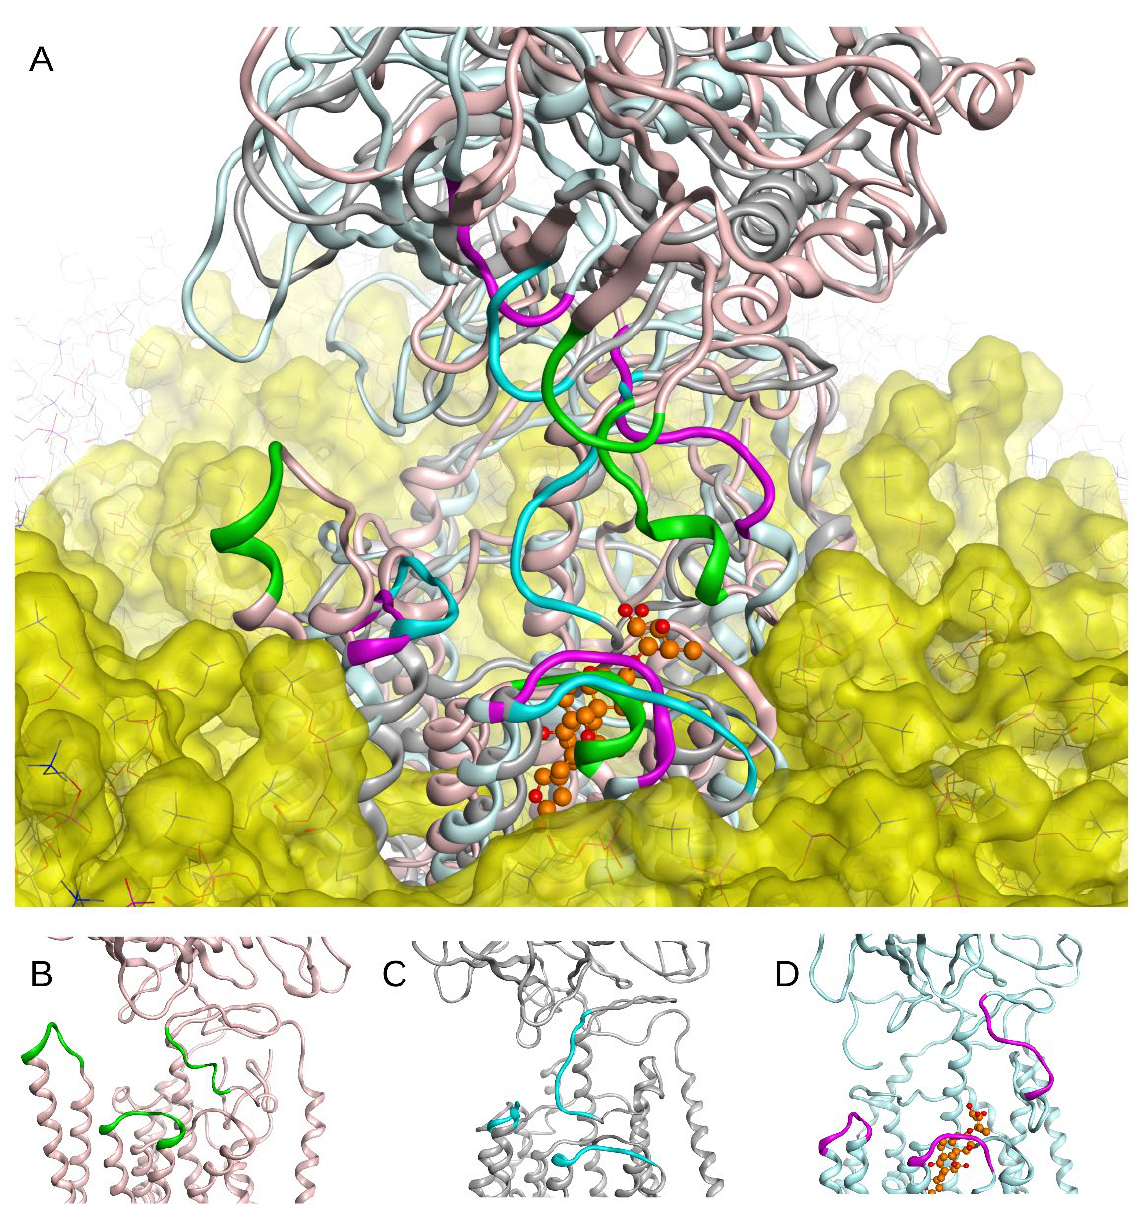
Figure 2. Superposition of Na,K-ATPase E1P, E2P states and Na,K-ATPase in complex with ouabain (OBN) embedded in DDPC membrane after 50 ns of MD ( A ). The Na,K-ATPase structure is shown in ( B – D ) for E1P ( B ), E2P ( C ), and OBN ( D ) states. The residues whose positions differed between conformations are shown with green (E1P), cyan (E2P), and magenta (OBN). Ouabain atoms are shown in orange.